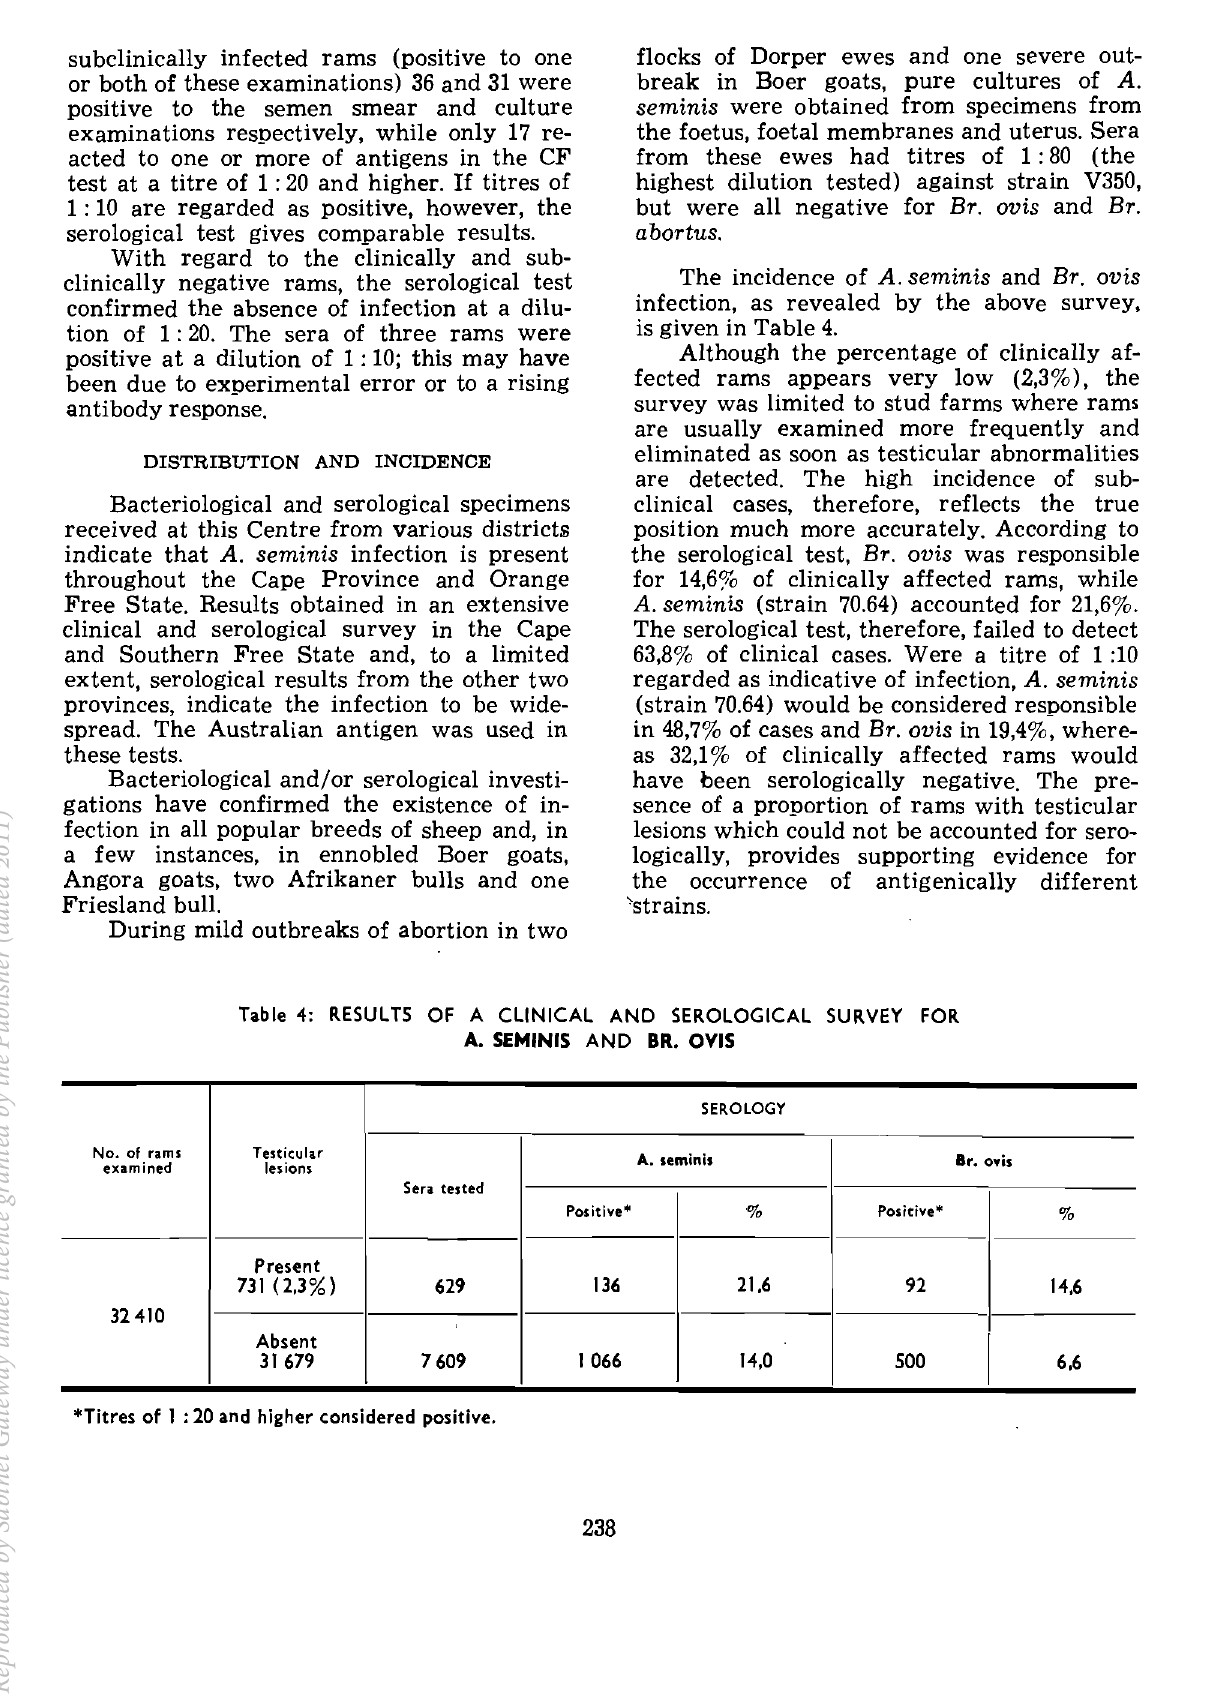
Table 4: RESULTS OF A CLINICAL AND SEROLOGICAL SURVEY FOR A. SEMINIS AND BR.